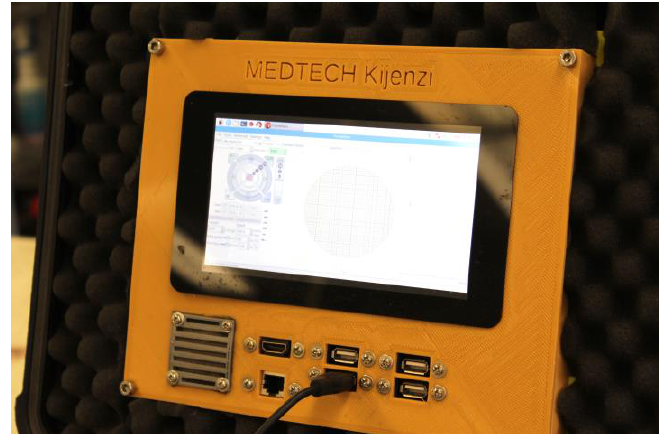
Figure 9. Close-up of the on-board computer.